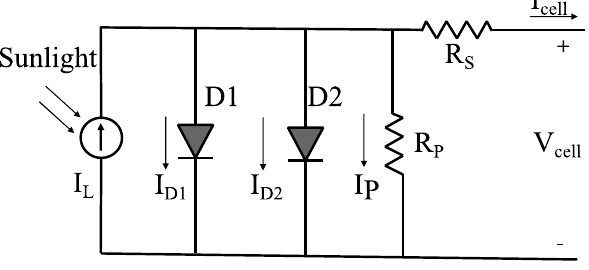
Figure 4. Double-diode model of a photovoltaic cell.